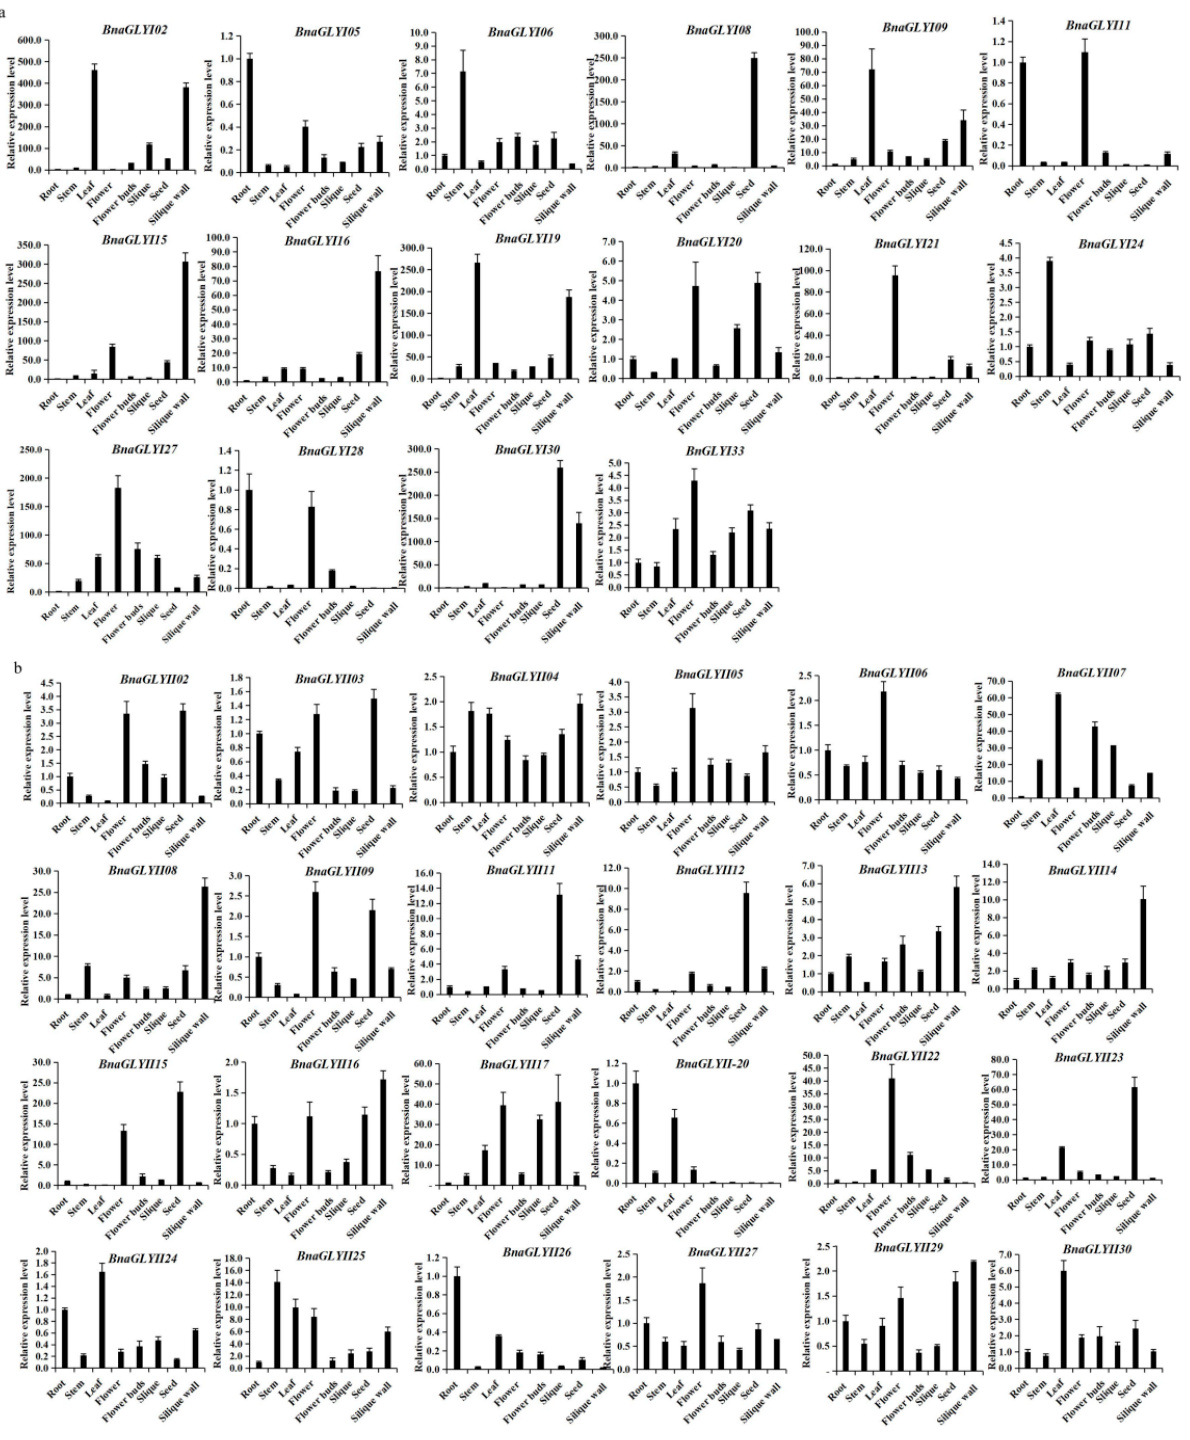
Figure 5. Relative expressions of the BnaGLYI ( a ) and BnaGLYII ( b ) genes in different tissues of B. napus confirmed by qRT-PCR. The normalized relative quantity in the root was set as